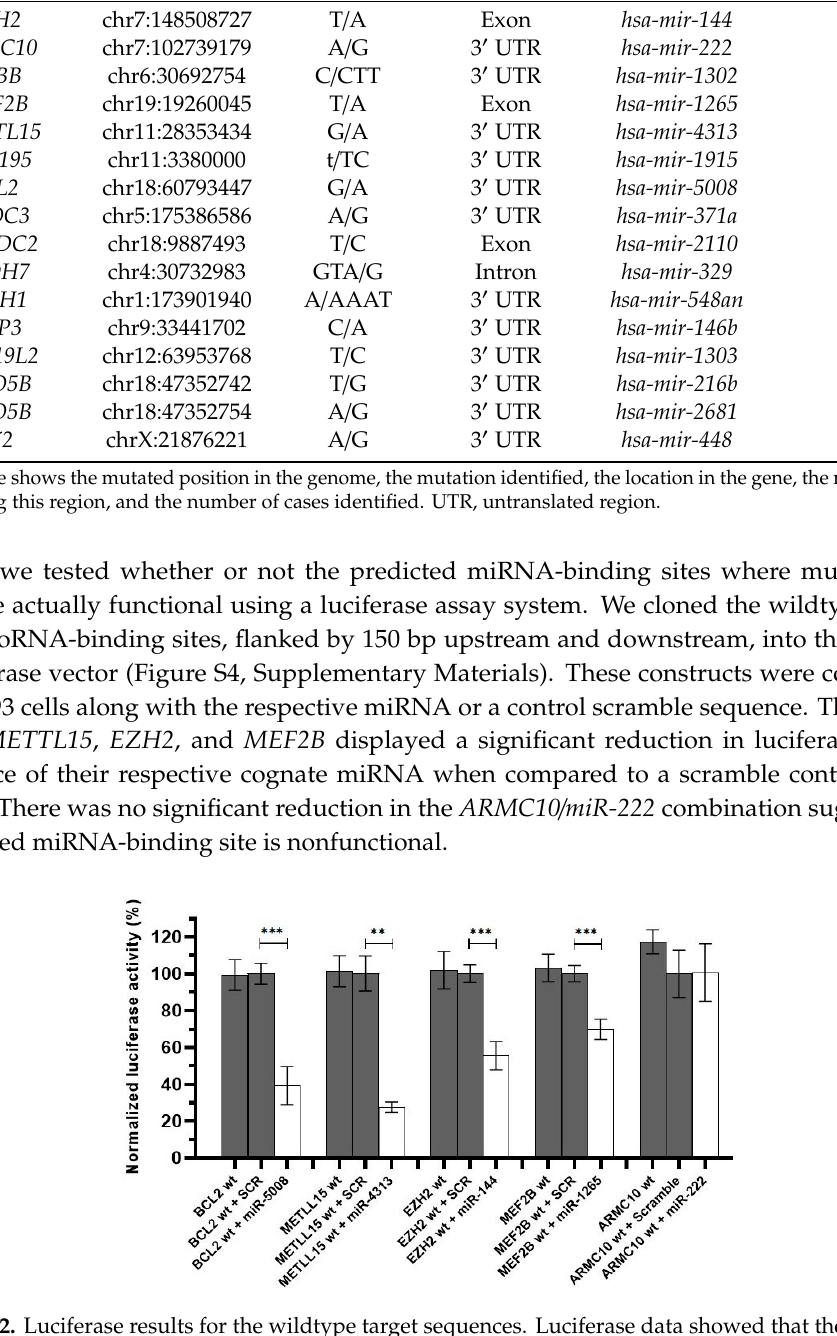
Figure 2. Luciferase results for the wildtype target sequences. Luciferase data showed that the binding sites in BCL2 , METTL15 , EZH2 and MEF2B for miR-5008 , miR-431 , miR-144 , and miR-1265 , respectively, were functional. A downregulation in the luciferase activity can be appreciated under the effect of the miRNA compared to the control conditions. This was not the case for the predicted binding site in ARMC10 gene. SCR refers to a scramble miRNA sequence used as a negative control. *** p < 0.0001, ** p < 0.01.